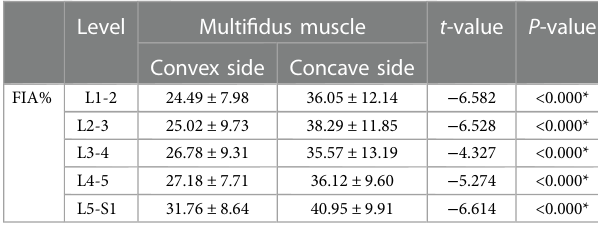
and mismatch groups The asymmetric degeneration degree of the multi fi dus muscle in the PI-LL match group was 8.91 ± 4.61 (%), and in the PI-LL mismatch group, it was 10.35 ± 5.44 (%), and there was no statistical difference between the two groups ( P > 0.05, see Table 4 ). The average degeneration degree of the multi fi dus muscle in the PI-LL mismatch group was 32.22 ± 6.98 (%), which was higher than that in the PI-LL match group, which was 26.28 ± 6.23 (%) ( P < 0.05, Table 4 ).